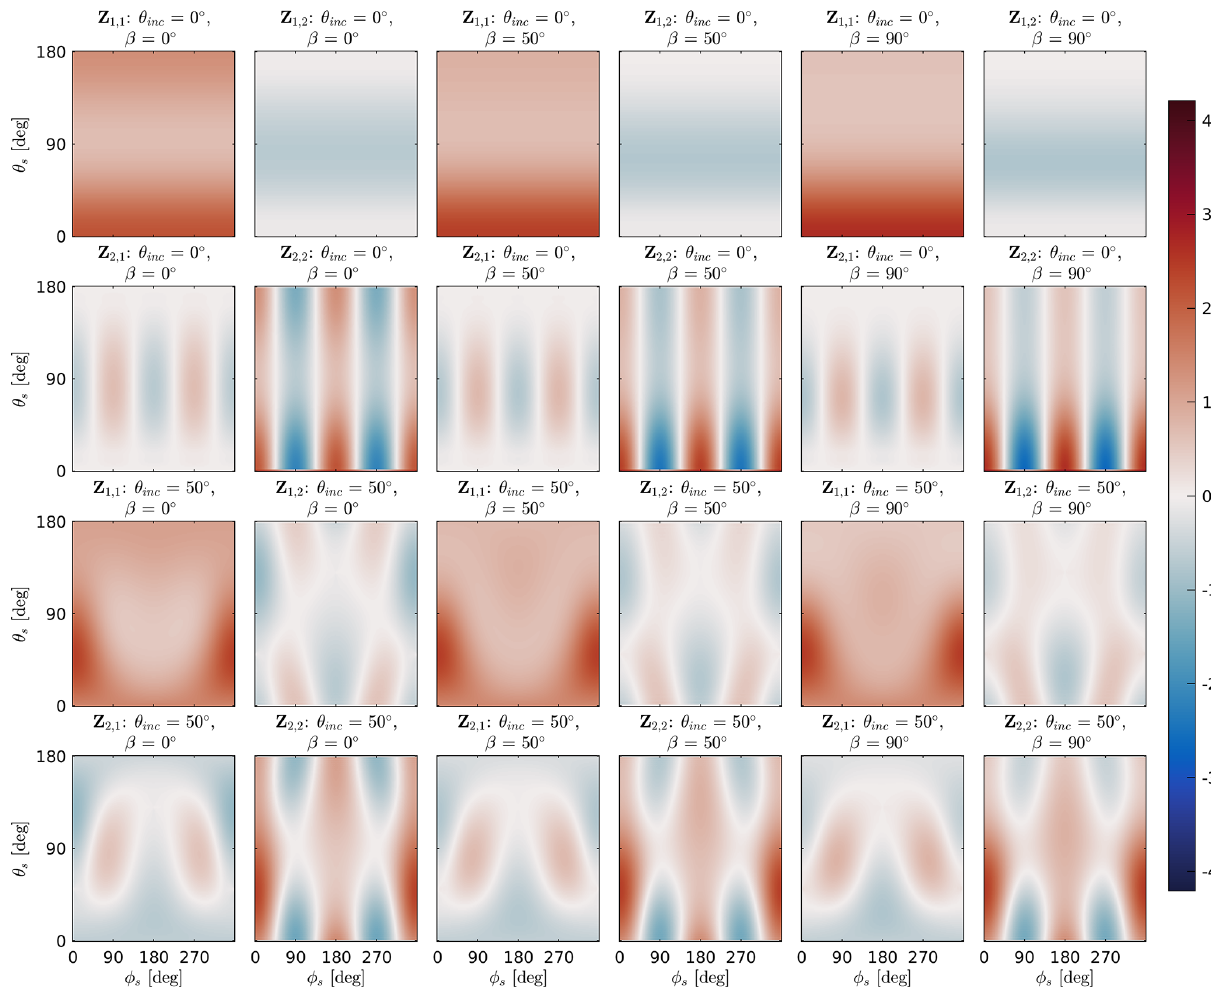
Figure 11. The upper-left block of the normalized scattering matrix ˆ Z of large plate aggregate with a volume-equivalent diameter of 427µm (Fig. 4) at 167GHz, as a function of the polar scattering angle θ s and the azimuth scattering angle φ s for a set of tilt angles β and incidence angles θ inc . A volume-equivalent diameter of 427µm at 167GHz corresponds to size parameter x ≈ 0 . 75.